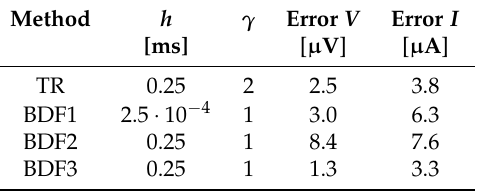
Table 8. RLC circuit: High-precision configuration of the DAE integration methods.